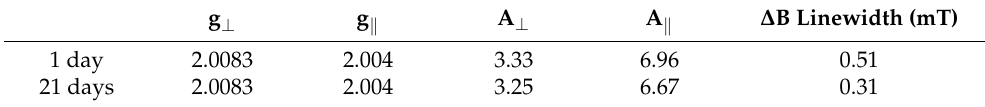
Table 4. Spectroscopic parameters of the spin Hamiltonian (2) of the nitrogen radical in hydroxyapatite. g ⊥ g (cid:107) A